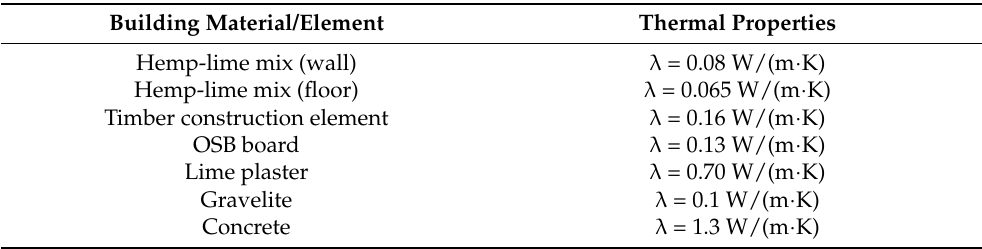
Table 3. Boundary conditions adopted in modelling.